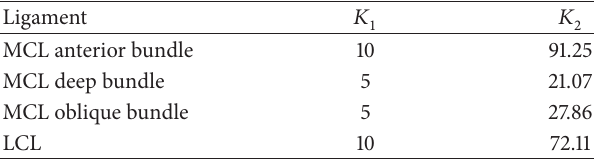
Table 1: The stiffness coefficients of MCL and LCL.